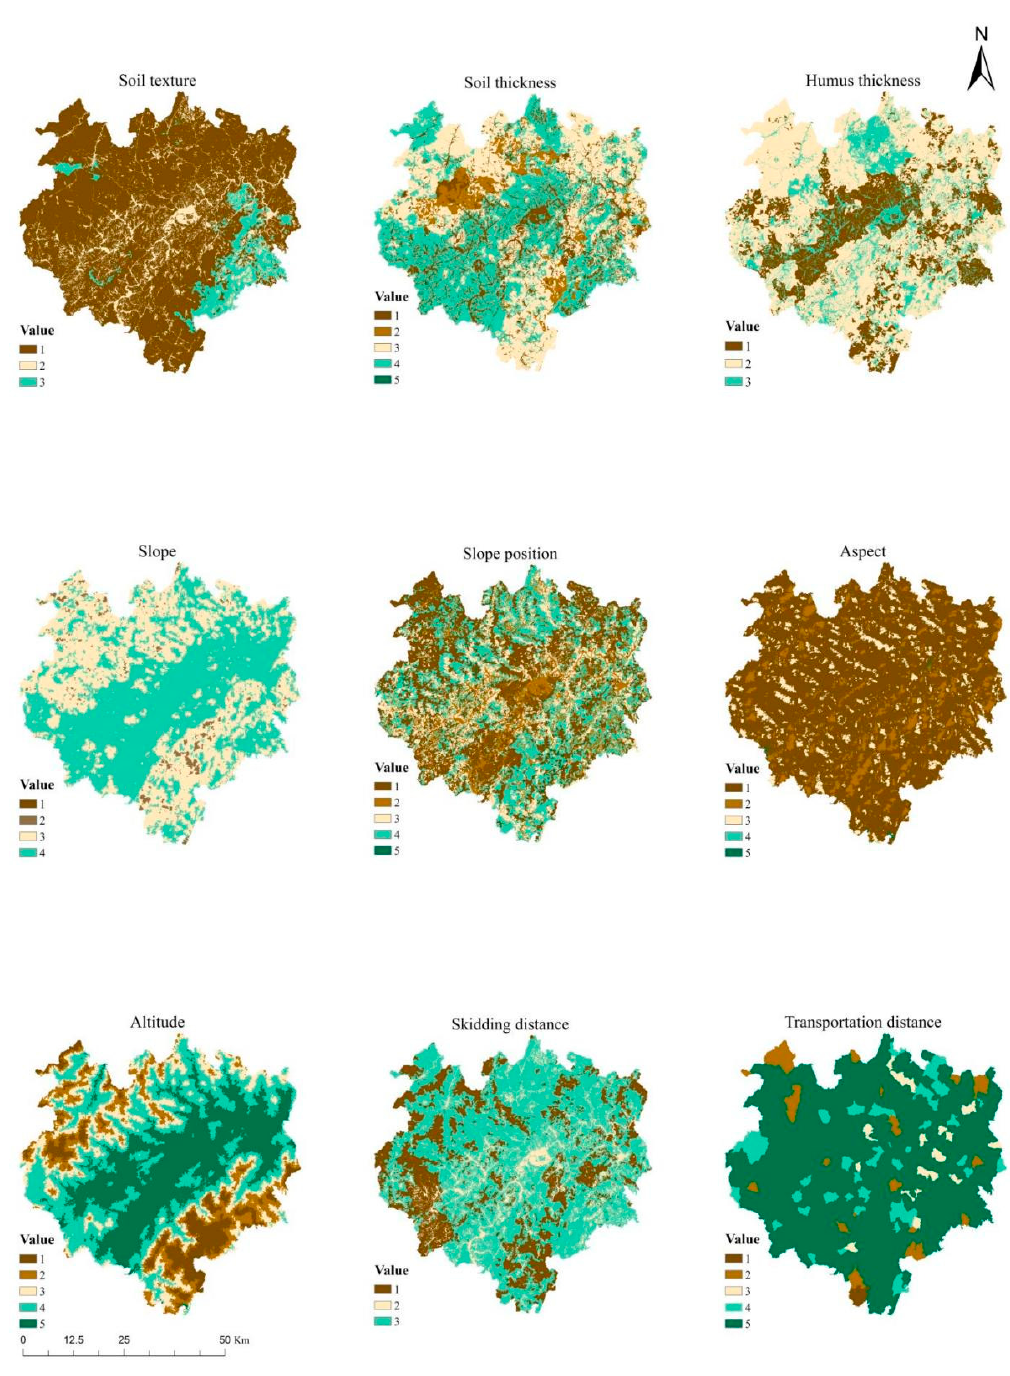
Figure 3. Data reclassification of each indicator.